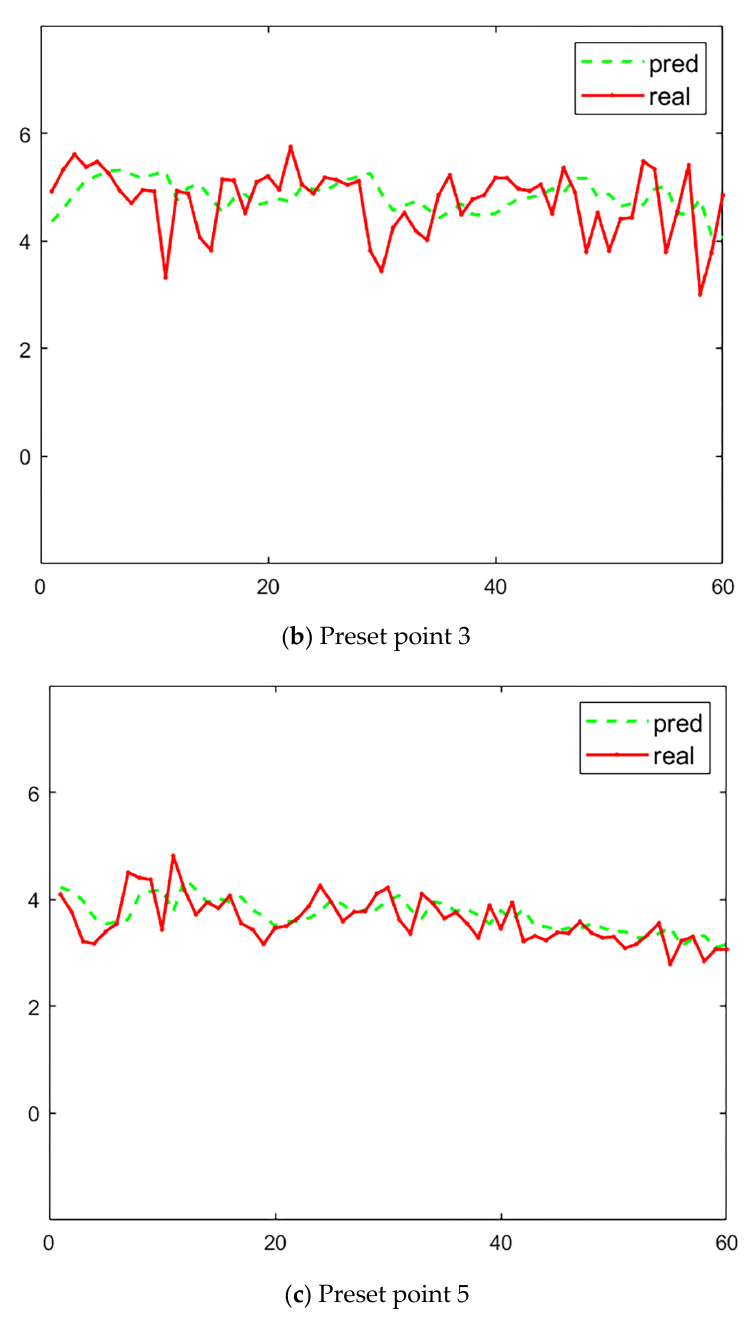
Figure 9. The results of the GRU model prediction.